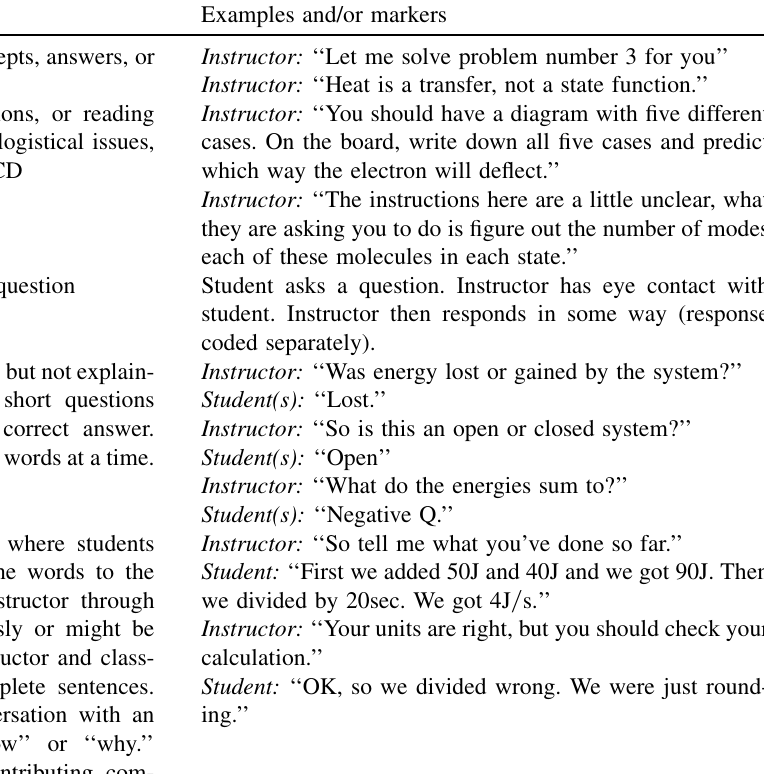
TABLE I. A list of all possible instructor-student interactions captured by RIOT